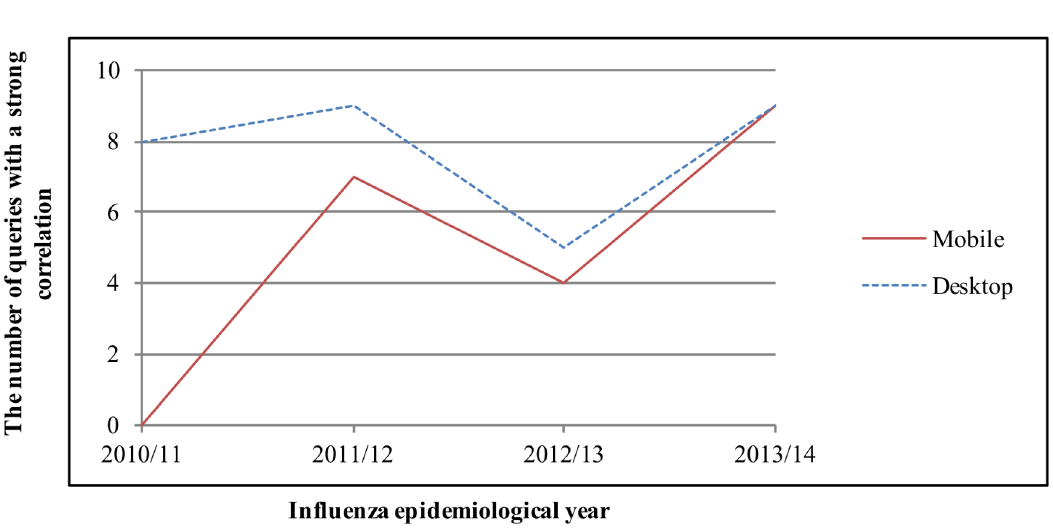
Fig 1. Time series plots of number of search queries having a strong correlation (r-value of (cid:1) 0.7) with KCDC ILI data.